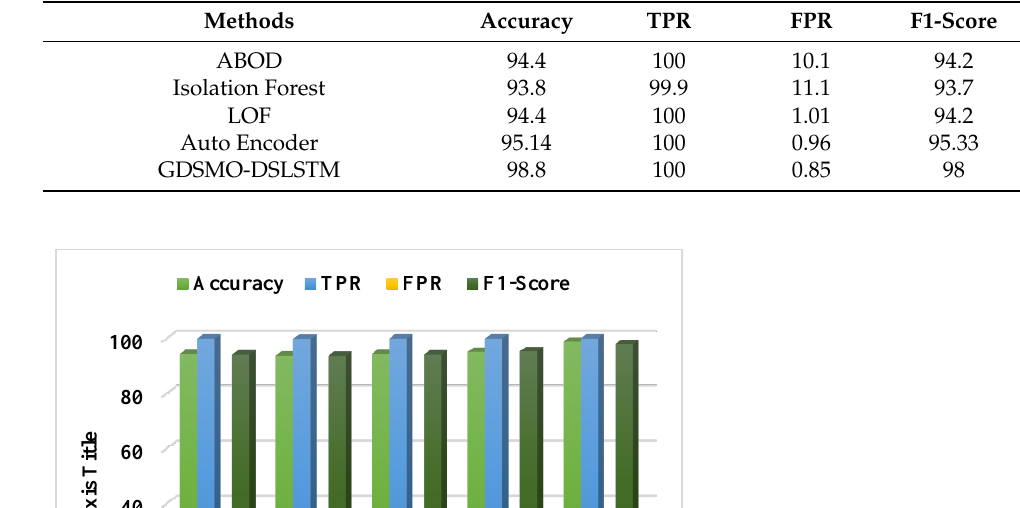
Table 4. Analysis based on accuracy, TPR, FPR, and F1-score.